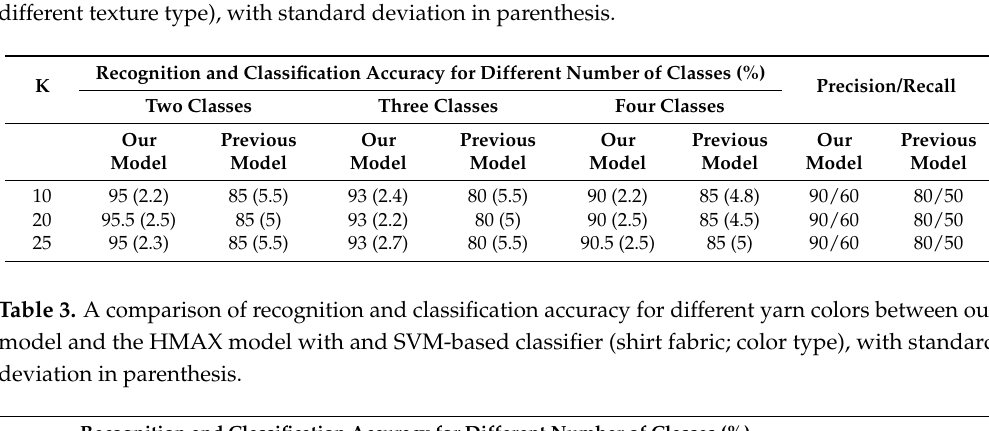
Figure 5. Sample of the images in the dataset to capture feature invariance for a test. Table 2. A comparison of recognition & classification accuracy for different types of textures between our model (deep ELM based classifier) and the HMAX model with an SVM-based classifier (shirt fabric; different texture type), with standard deviation in parenthesis.